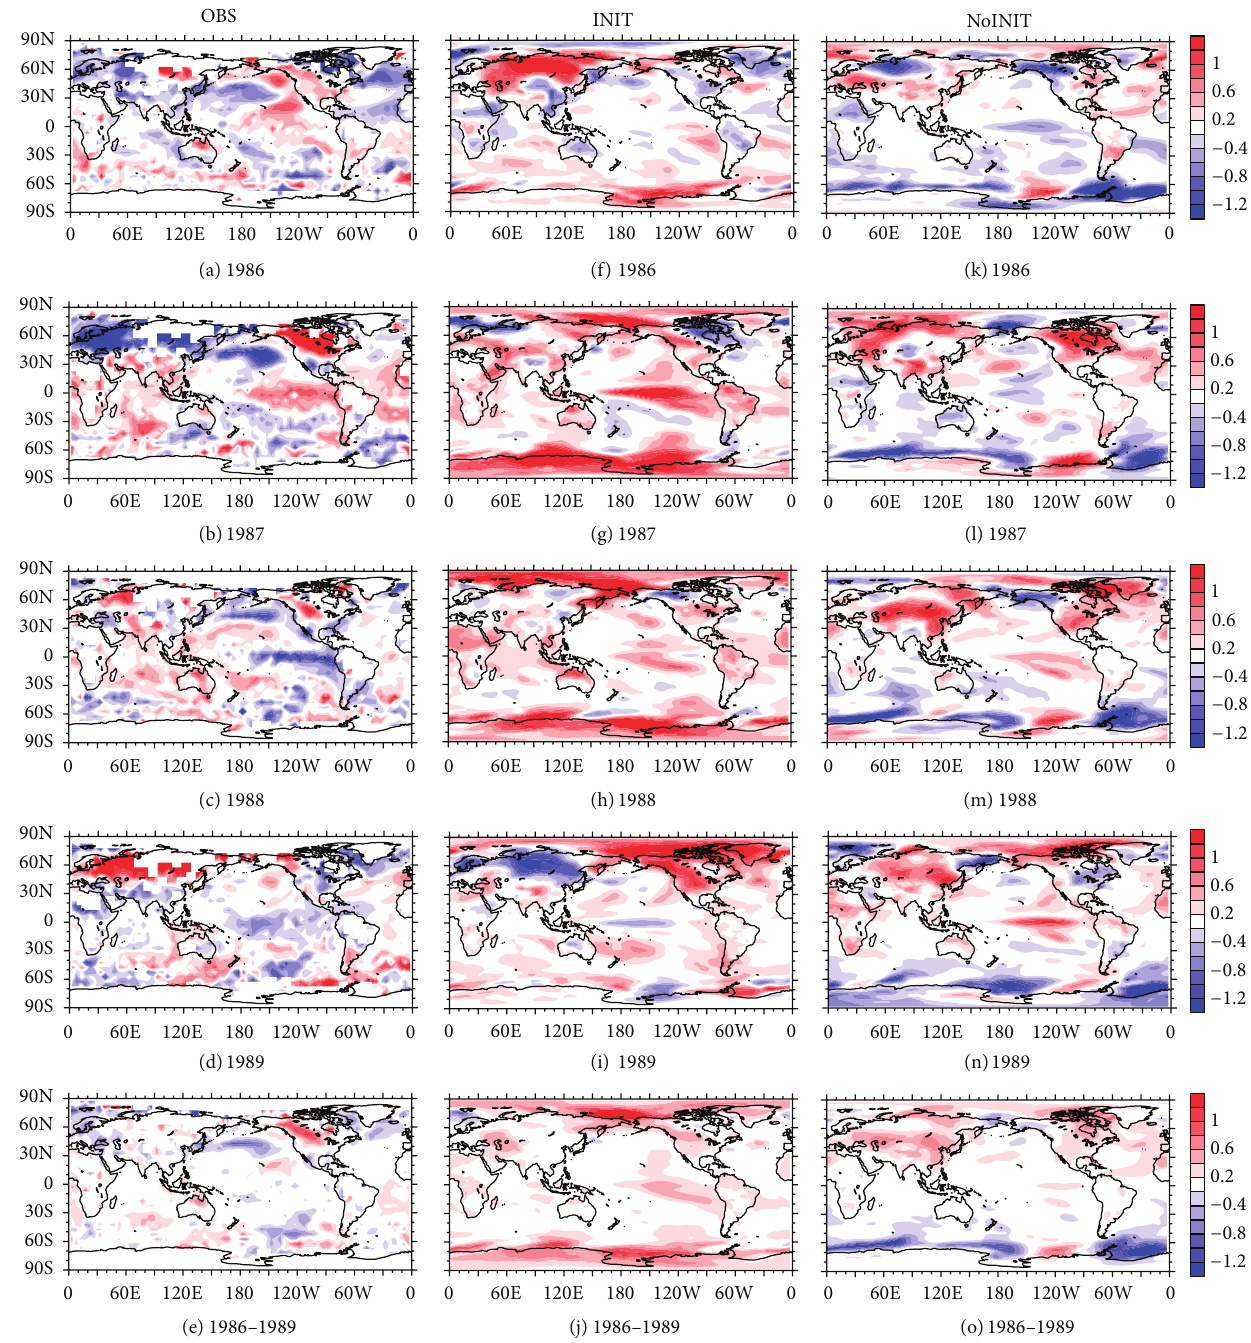
Figure 4: Left panel: (a)–(d) annul mean SST anomalies from 1986 to 1989 derived from the observation (units: K). (e) Average of (a)–(d). Center (right) panels: as in the left panel but from the ensemble mean of the INIT (NoINIT) runs.